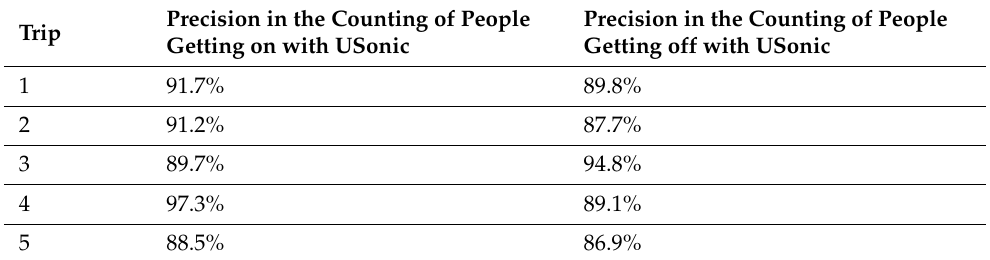
Table 10. The results obtained of the passenger